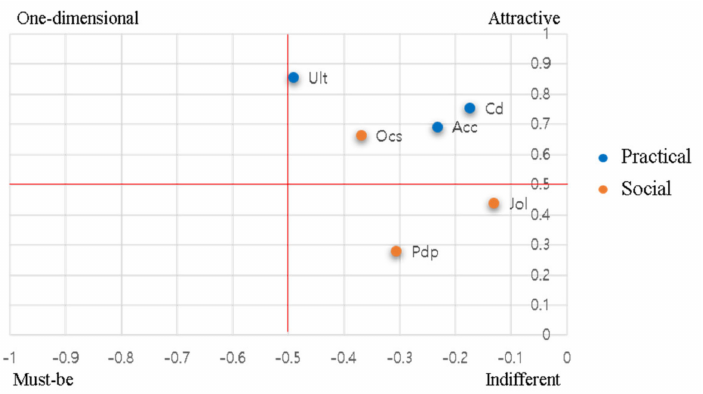
Figure 7. Factor positions for pleasurable